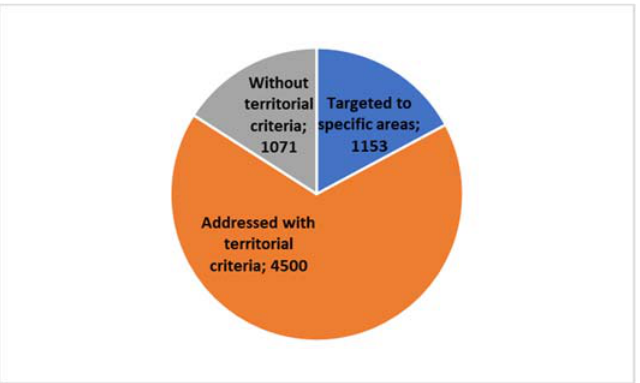
Figure 4. Calls for tenders according to the territorial targeting (expenditures in million EUR). Source: authors’ data base of calls for tender.